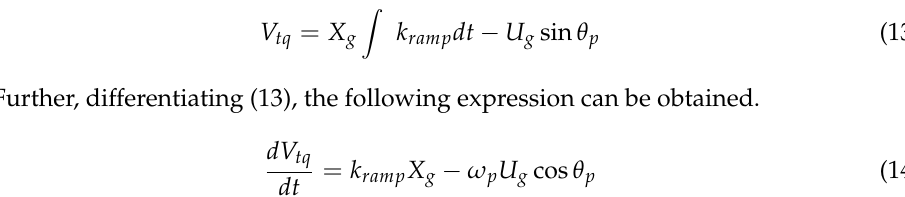
Figure 9. Phase dynamics of internal voltage in stage of active power climbing.